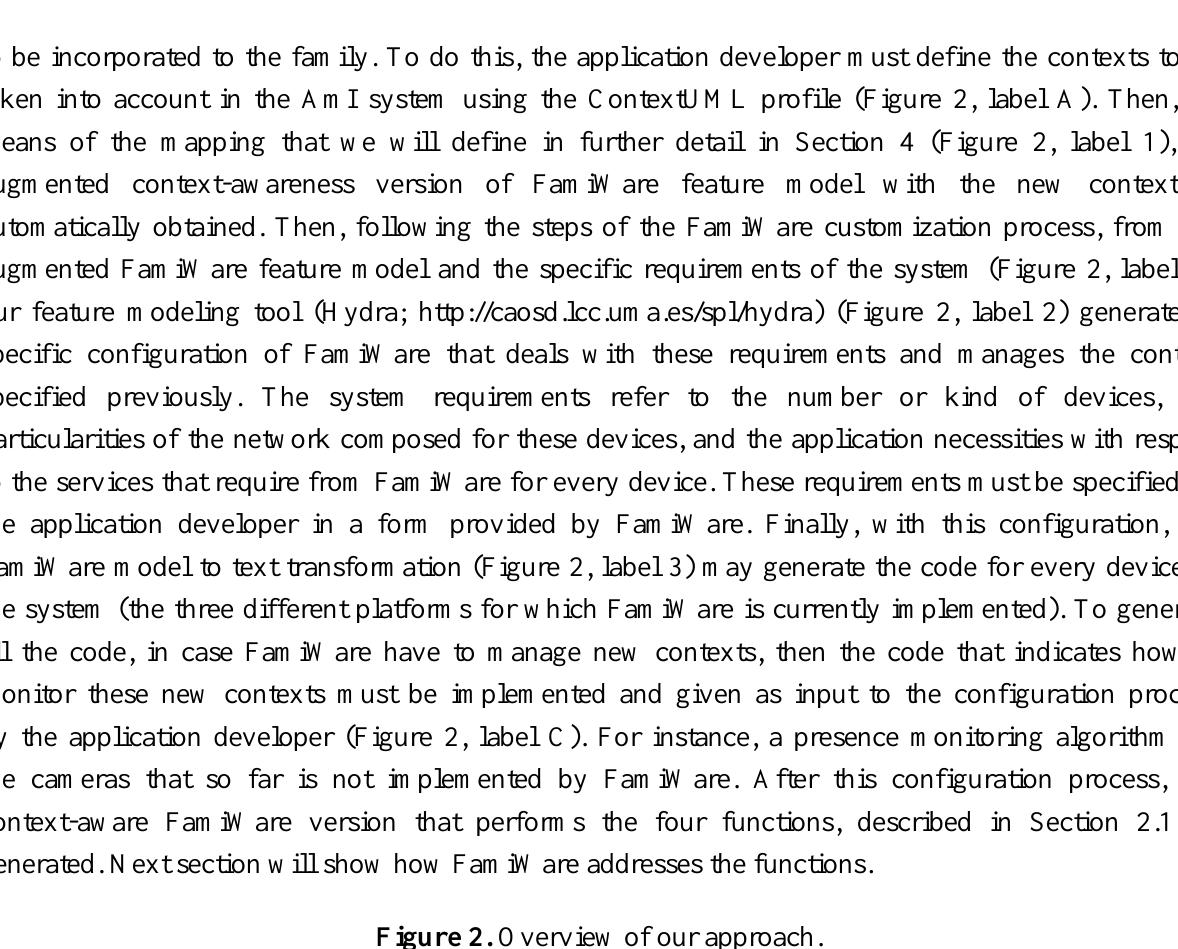
Figure 2. Overview of our